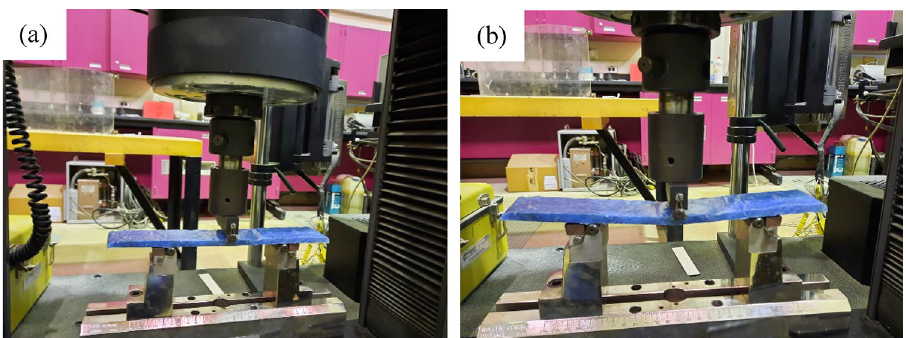
Figure 8. The Universal Testing Machine used for the three-point bending moment test; ( a ) before the test and ( b ) after the test.